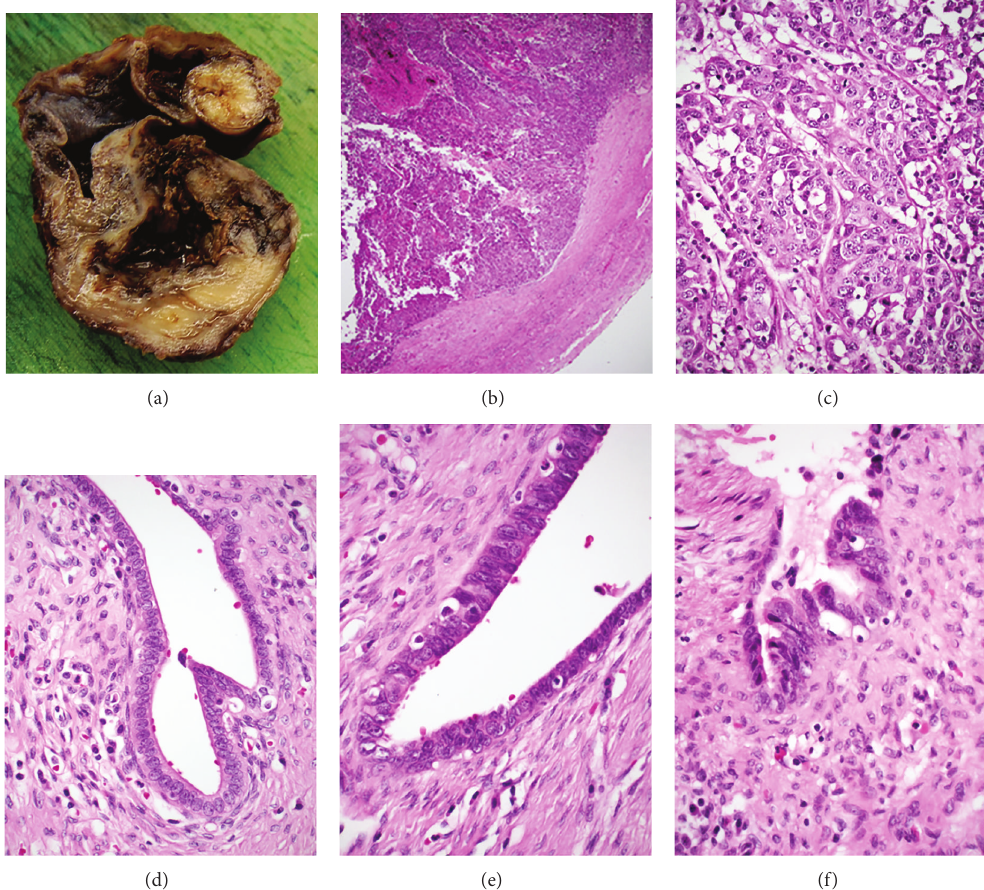
Figure 1: (a) is the macroscopic image of the left fallopian tube which is totally destroyed and cystic. Fleshy white masses are noted in the wall. The upper nodular mass protrudes into the lumen of the cystically dilated haemorrhagic tube. (b) is a low power view of the tube with the tumour protruding into the lumen (Haematoxylin and Eosin stained section, original magnification of × 4). (c) is high power view of the tumour (Haematoxylin and Eosin stained section, original magnification of × 60). (d) shows the benign tubal epithelium (Haematoxylin and Eosin stained section, original magnification of × 60) and (e) and (f) show dysplastic tubal epithelium with loss of polarity, stratification, and nuclear pleomorphism (Haematoxylin and Eosin stained sections, original magnification of ×